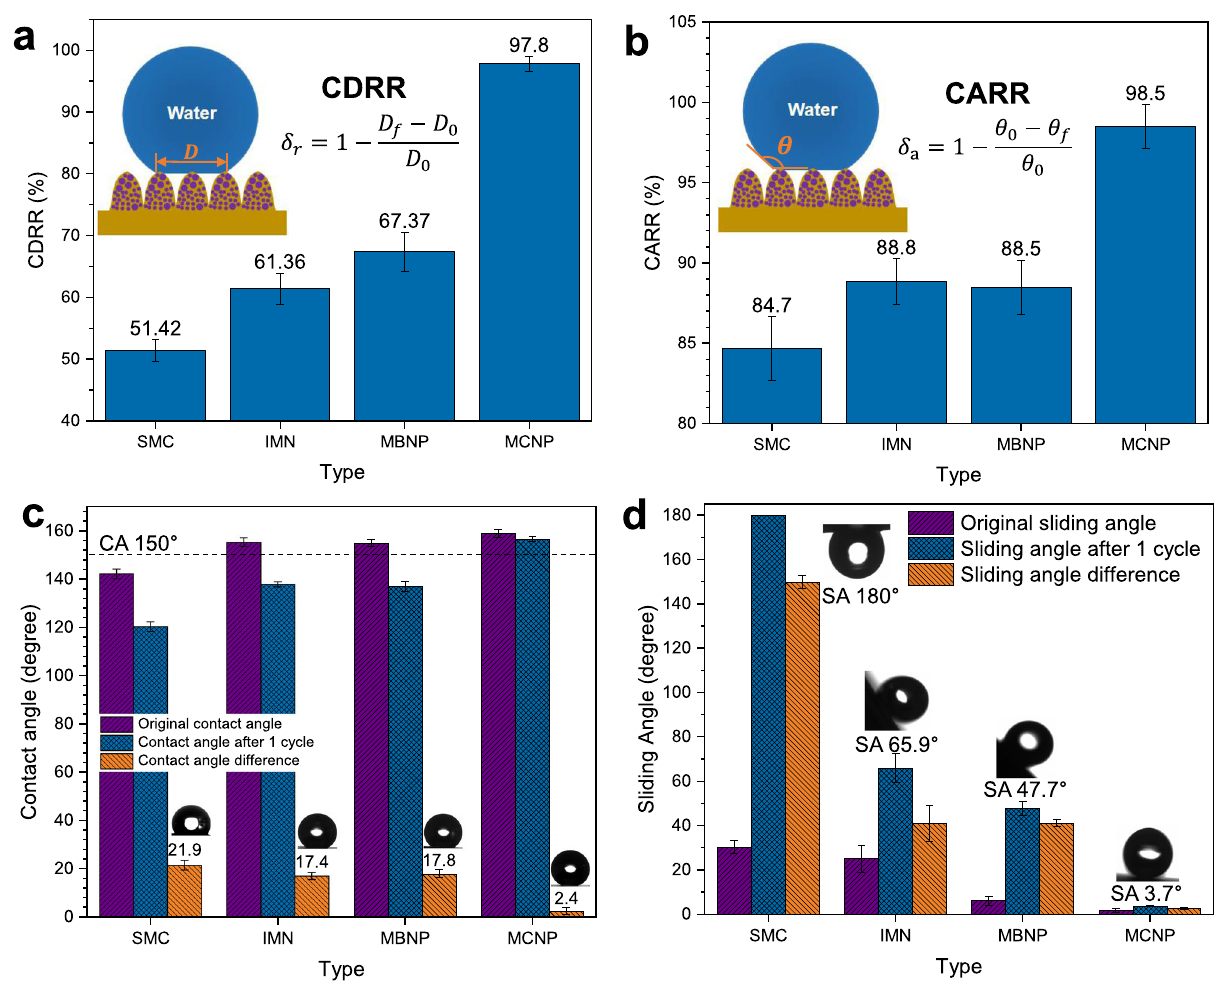
Fig. 3 The contact diameter recovery rate (CDRR), the contact angle recovery rate (CARR), contact angle, and sliding angle changes of droplets on the four hydrophobic surfaces after the icing & melting cycle. a and b CDRR and CARR of droplets on the four surfaces after icing and melting. c Comparison of the original contact angles (CA), contact angles after one cycle, and the contact angle differences on the four hydrophobic surfaces. d Comparison of the original sliding angles (SA), the sliding angles after one cycle and the sliding angle differences on the four hydrophobic surfaces. The CDRR ( δ r ) and CARR ( δ a ) represent the CB state recovery extents of droplets. They can be calculated by δ r ¼ 1 (cid:3) D f (cid:3) D 0 D fi nal contact diameter and contact angle after melting, the original contact diameter and angle, respectively. Schematics are inserted in a and b . The CA 150° boundary of superhydrophobicity is indicated with the black dashed line. Sliding angles of four surfaces after one cycle are marked. Data are mean ± s.d. from at least three independent